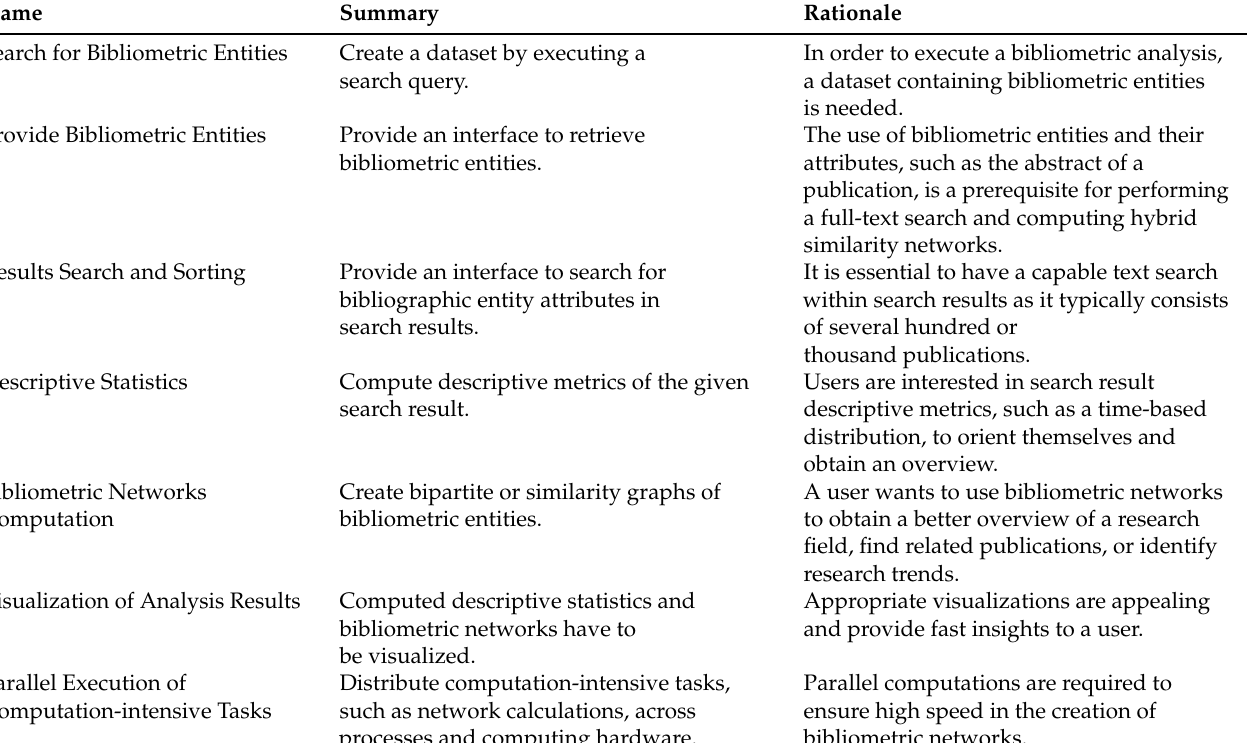
Table 1. Functional